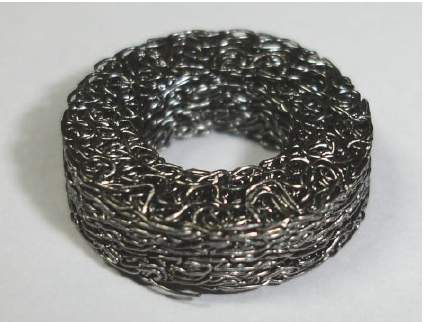
Figure 1: Pseudoelastic compressed SMA mesh washer isolator [21].